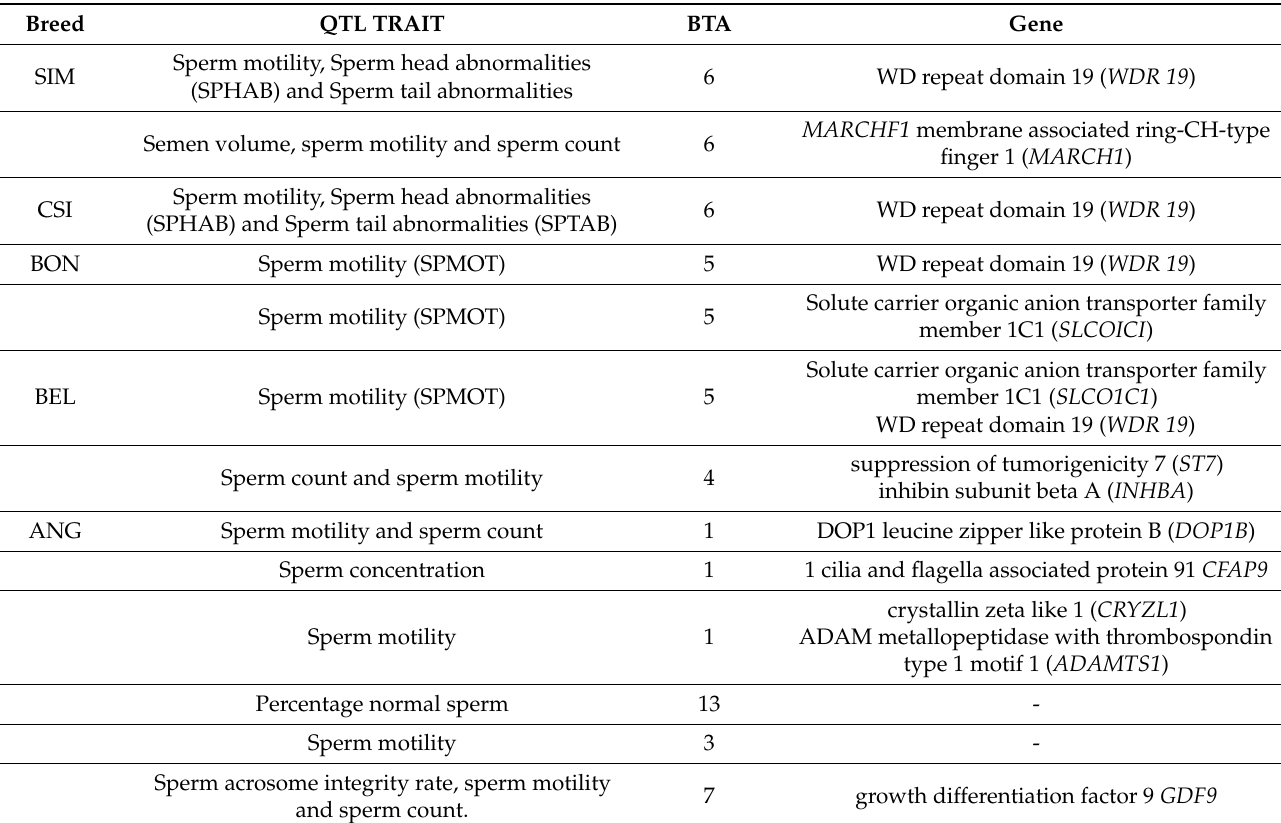
Table 2. Breeds, QTL, BTA, and gene of